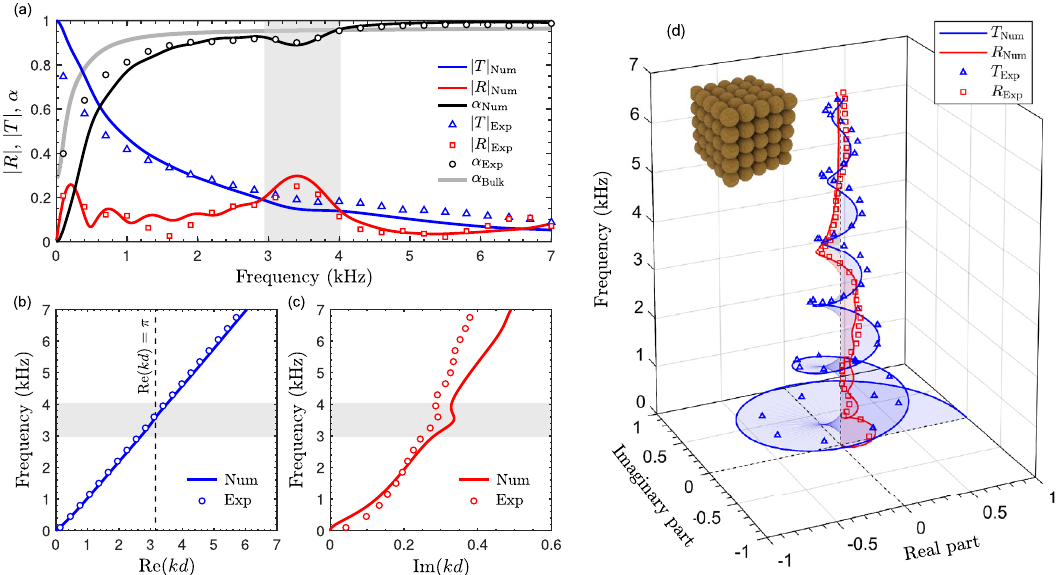
Figure 3. Scattering properties of a 3D primitive cubic arrangement of periodicity d = 43 mm, made of N = 6 Aegagropilae spheres of radius 19.5 mm. ( a ) Absorption, reflection and transmission coefficients calculated numerically (black, red and blue continuous curves) and measured experimentally (open black circles, open red squares, and open blue triangles). The grey continuous line represents the absorption coefficient of a bulk material of identical thickness. ( b ) Real and ( c ) imaginary parts of the complex wave number reconstructed numerically (continuous lines) and experimentally (markers). ( d ) Argand diagram of T (blue curve) and R (red curve) over the frequency range [0 Hz,7000 Hz] obtained numerically (continuous) and experimentally